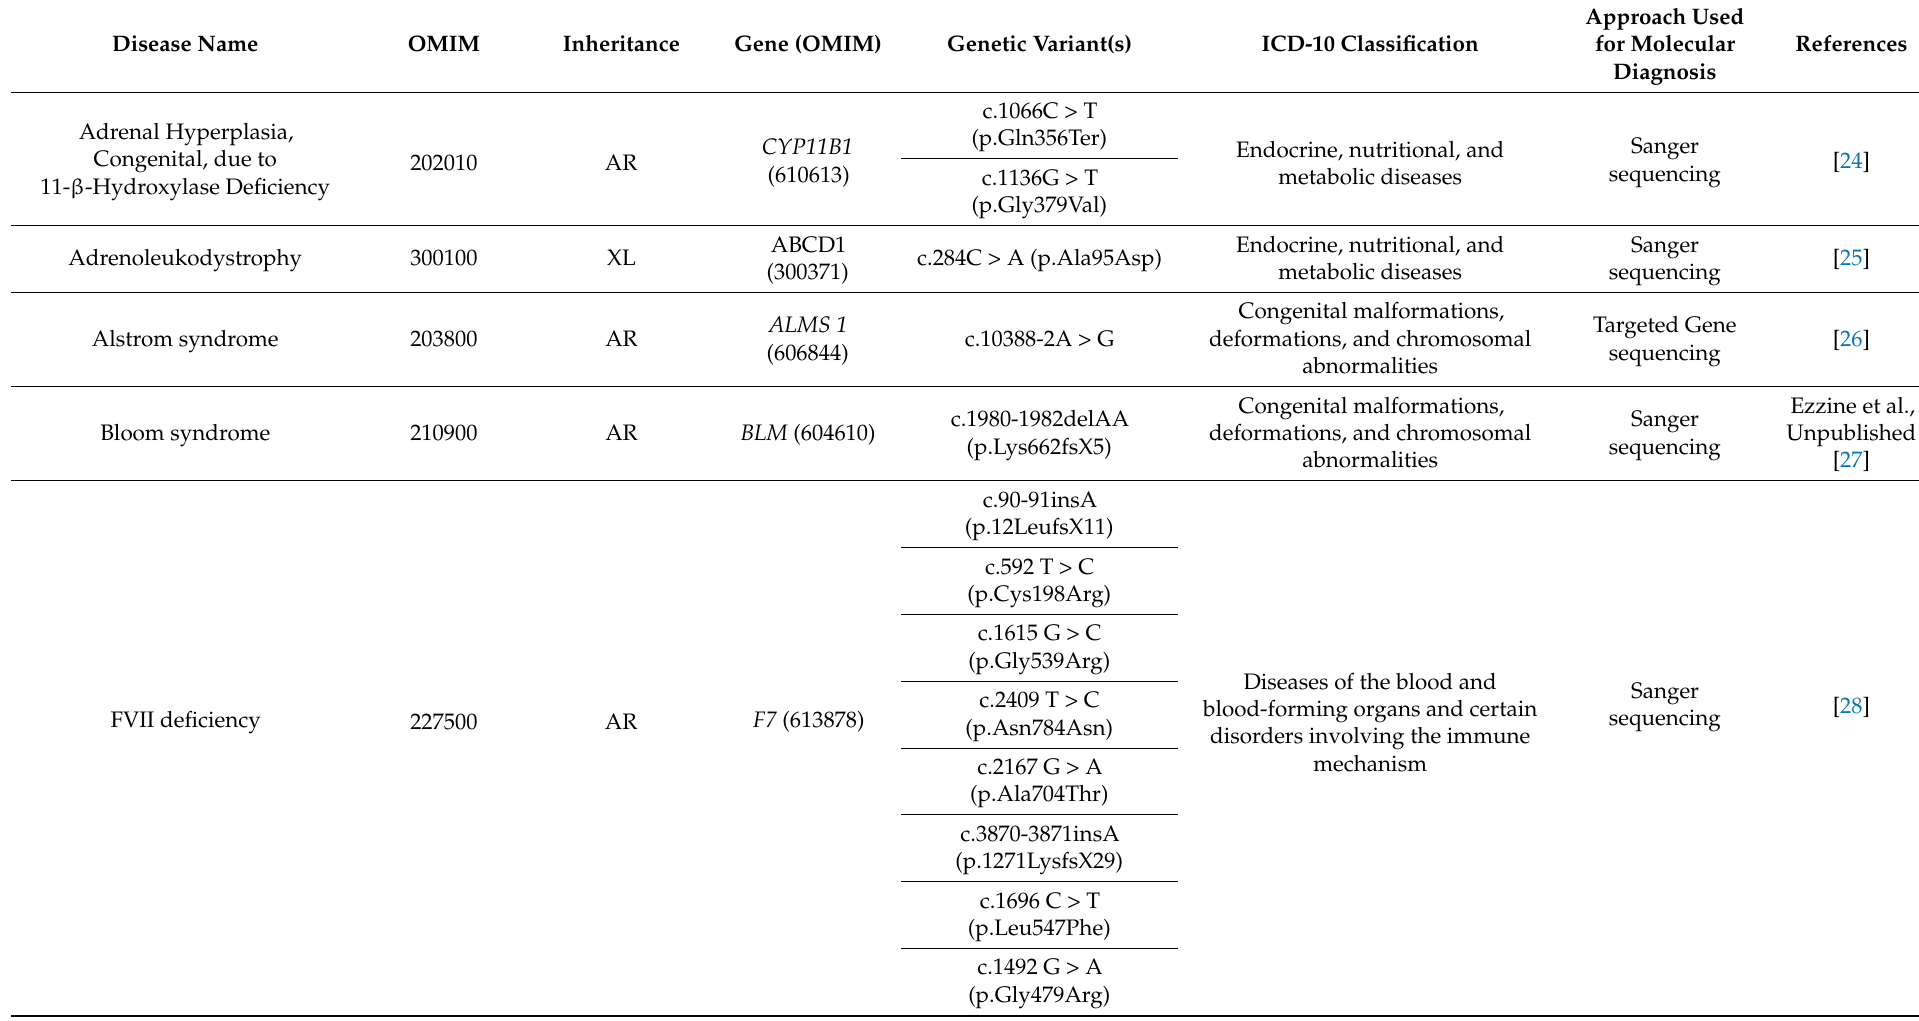
Table 1. Diseases with an identified molecular etiology determined in the last